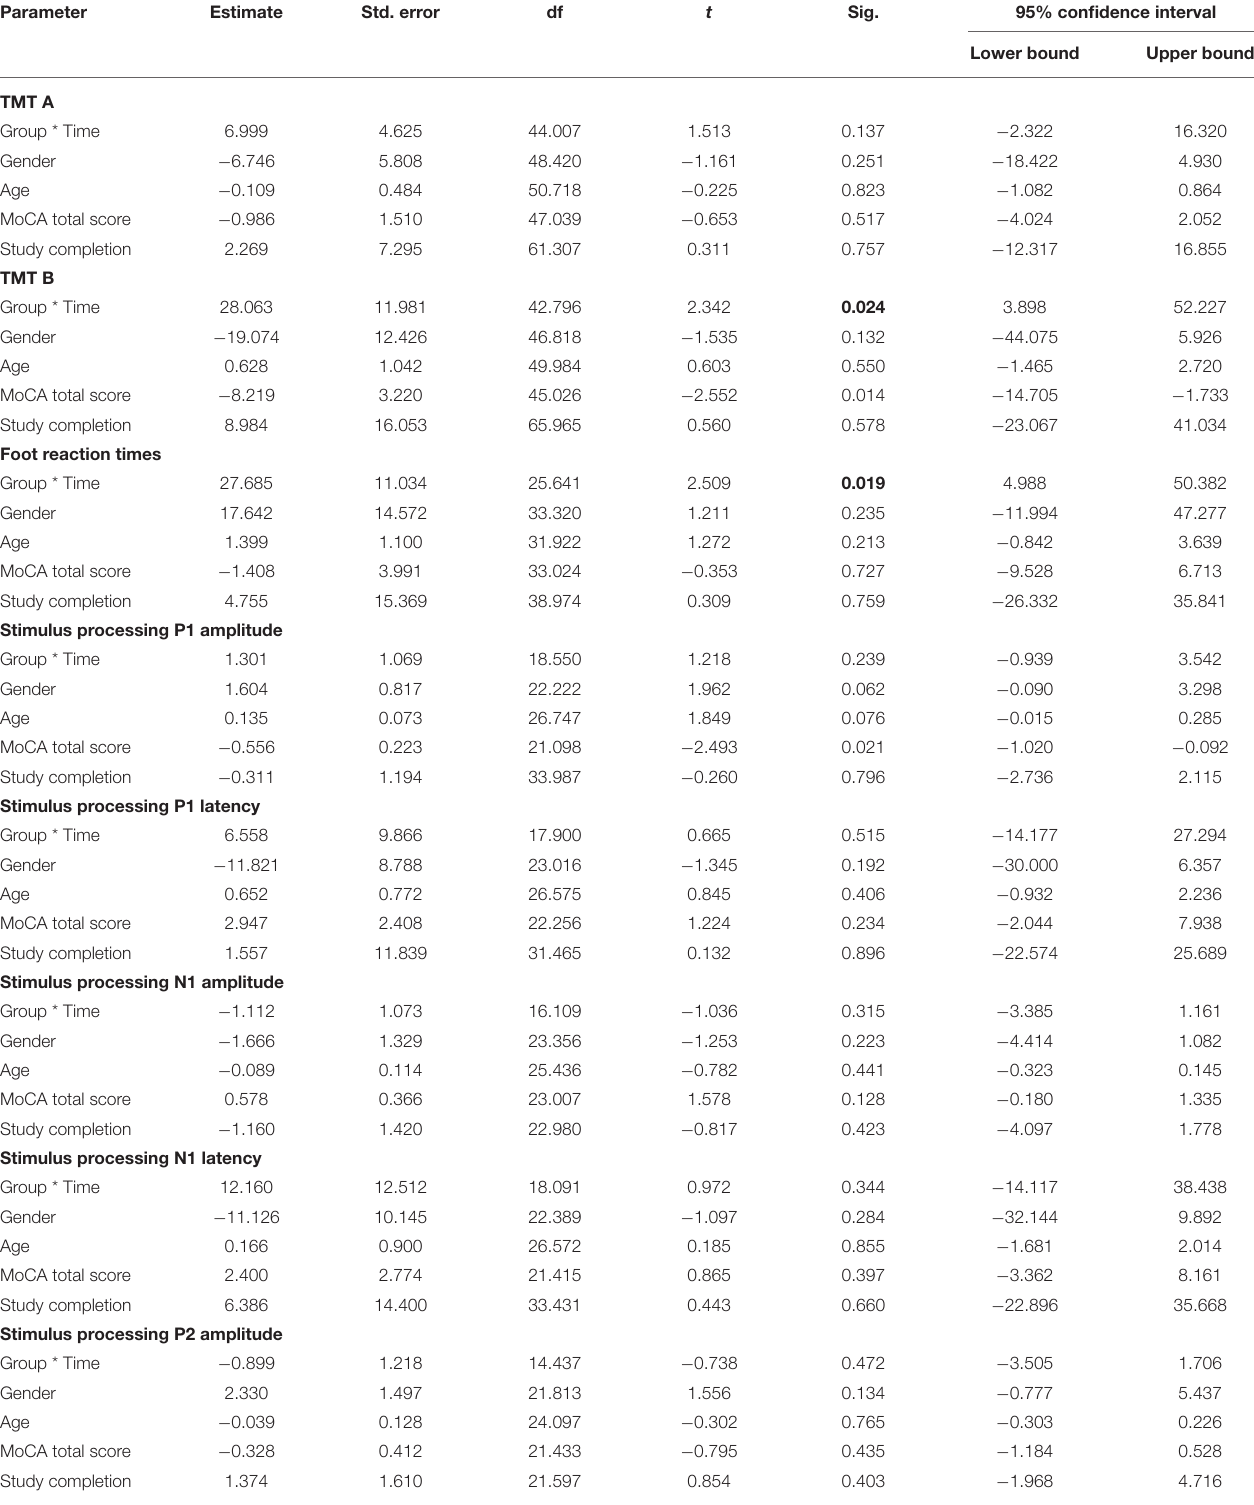
TABLE 3 | Mixed-effect linear model results for secondary outcome measures revealing Group, Time and Group × time interactions as well as covariates.